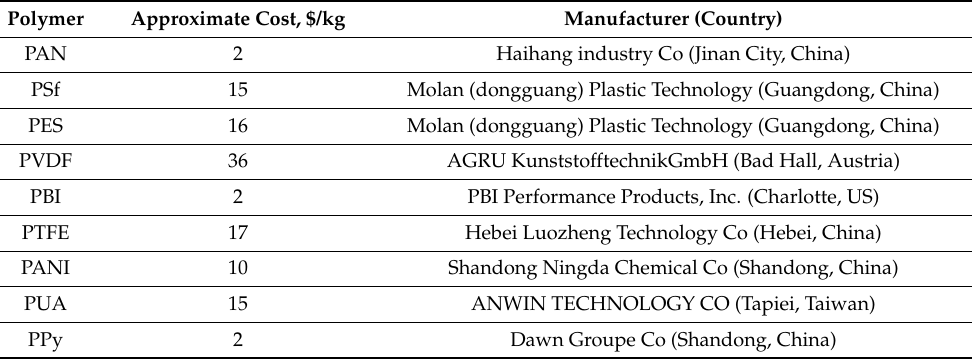
Table 6. The cost of polymers (it is assumed that 1 US dollar = 75